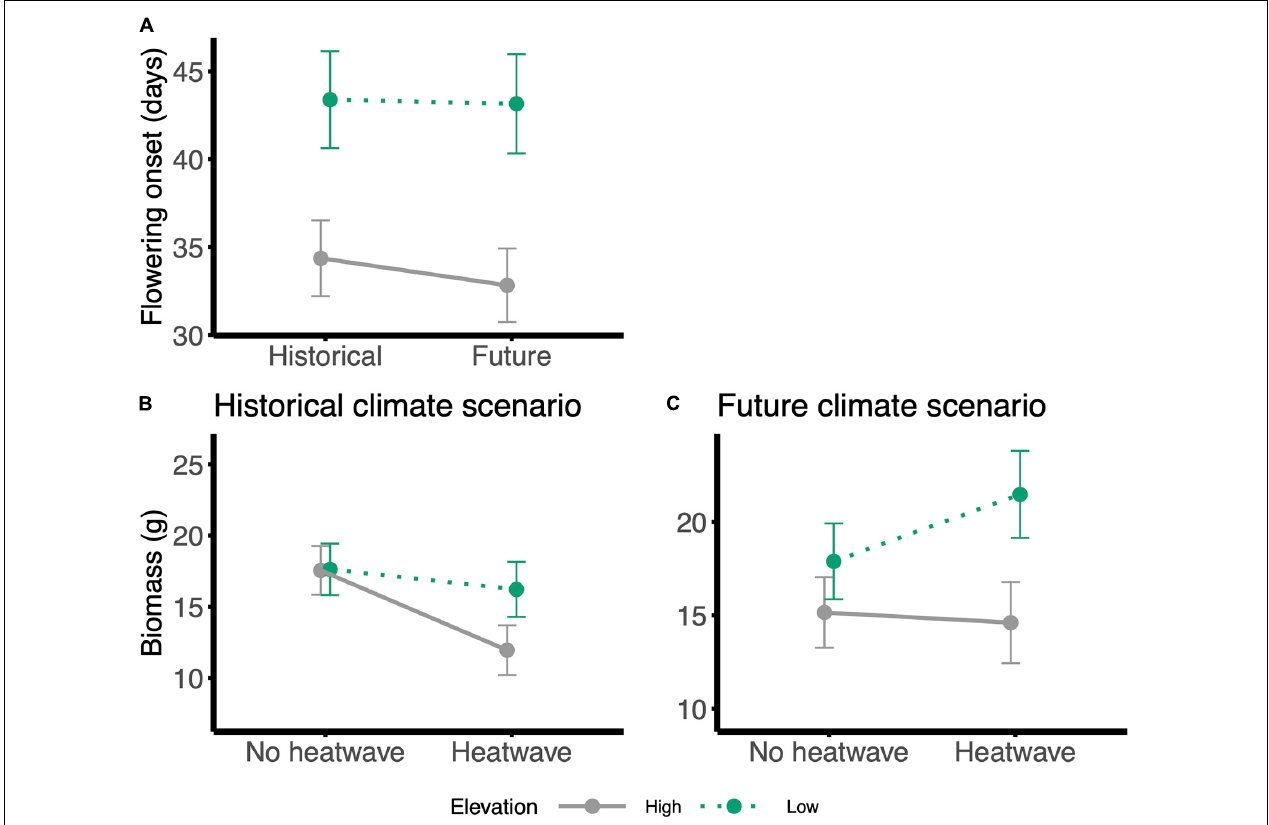
FIGURE 3 | Reaction norms for phenology and biomass traits: (A) flowering onset in response to the climate scenario, (B,C) biomass in response to the heatwave treatment, panel on the left: historical scenario; panel on the right: future climate scenario. Gray and solid lines = high-elevation families; green and dotted lines = low-elevation families. Values were estimated from the models using the emmeans function in ‘emmeans’ package, in R; error bars are standard